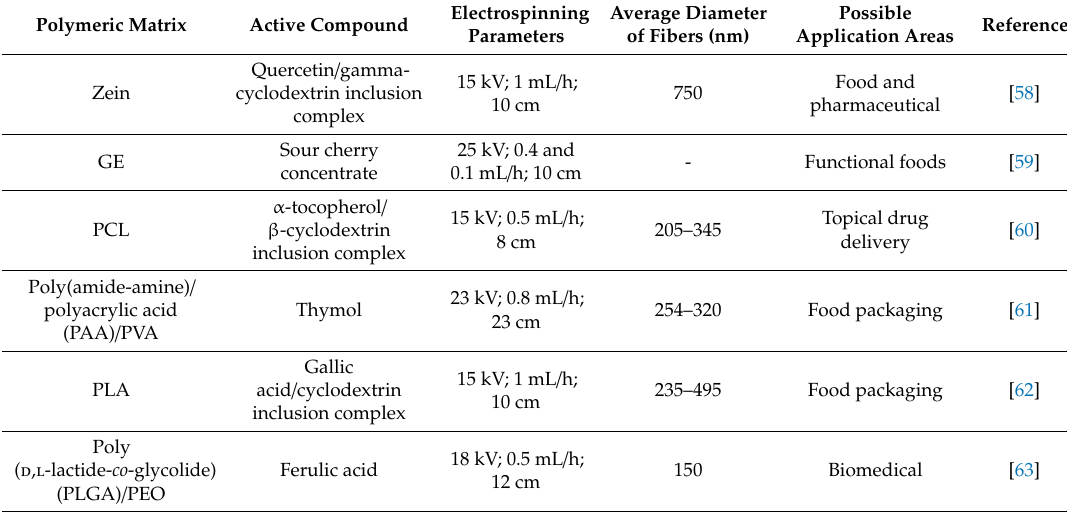
Table 4. Characteristics of antioxidant nanofibers from nine reviewed articles and proposed applications in